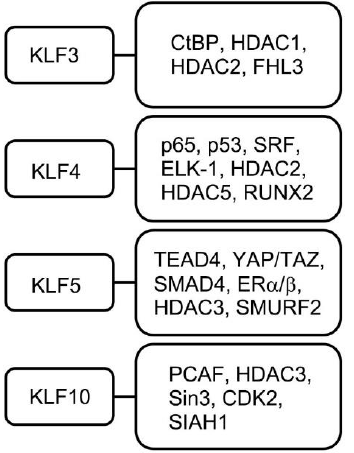
Figure 2. Physical and functional association partner molecules of KLF proteins intimately involved in